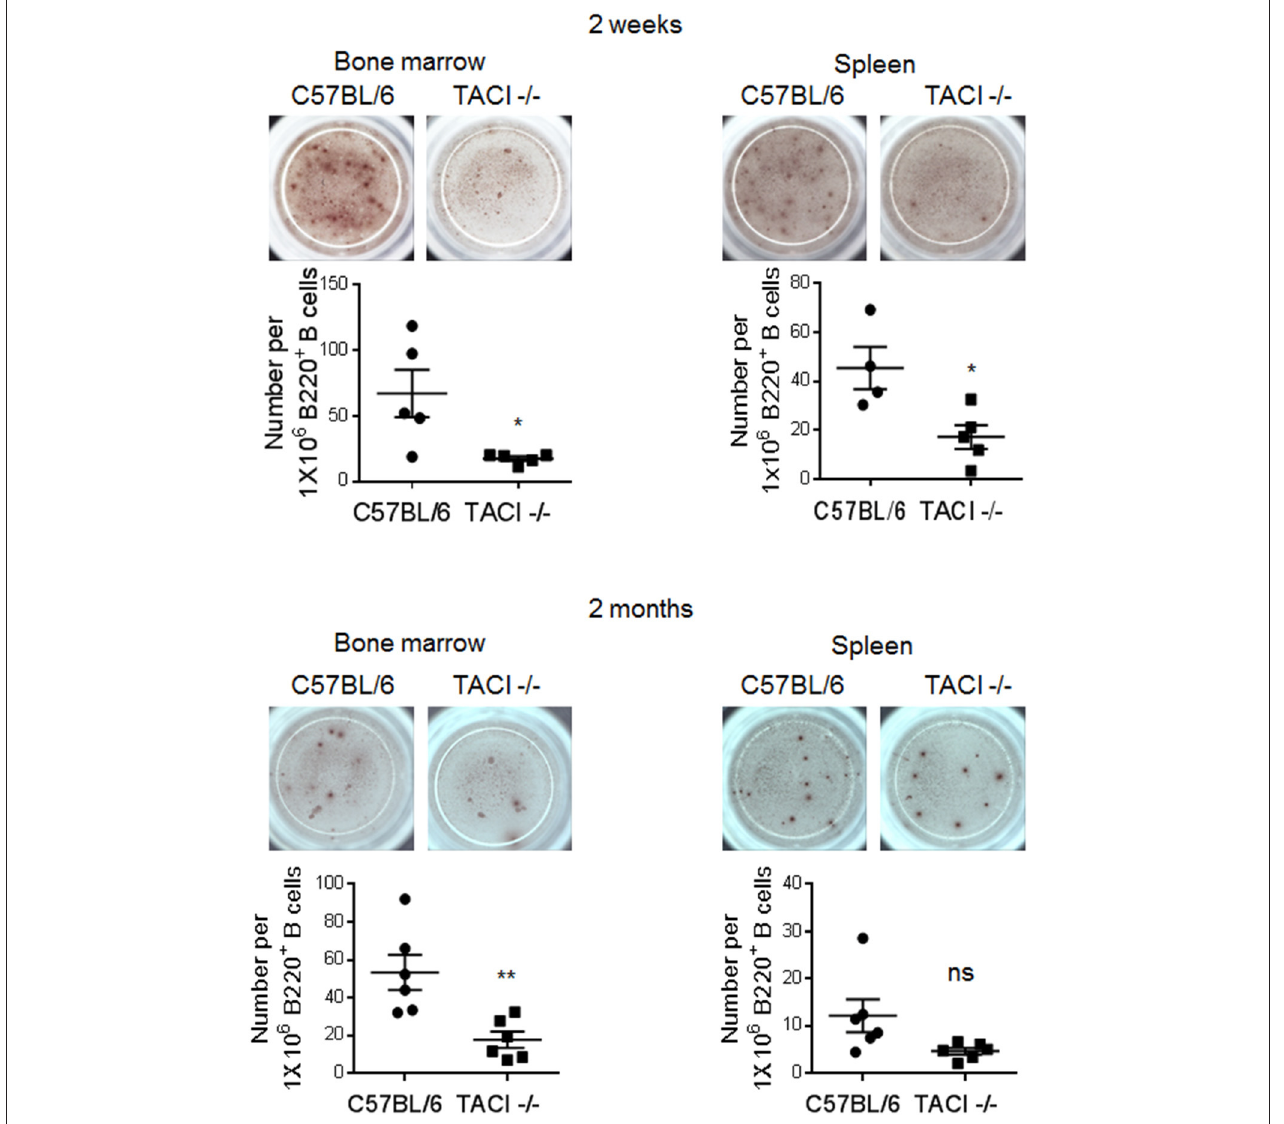
FIGURE 5 | TACI deficiency causes delayed generation of rMSP-1 19 -specific ASC. Spleens and bone marrow cells were harvested 2 weeks and 2 months post-infection to examine the frequency of antigen-specific IgG antibody secreting cells (ASC) in ELISPOT assay. The number of rMSP-1 19 -specific ASC per 1 × 10 6 B220 + B cells were quantified and plotted. Each data point represents one mouse. Unpaired Student’s t- test is used for statistical evaluation. Results are expressed as mean ± SEM ( n = 4–6) from one representative experiment out of two with similar results. * p < 0.05 and ** p < 0.01 indicate TACI -/- vs. C57BL/6 mice. ns, not